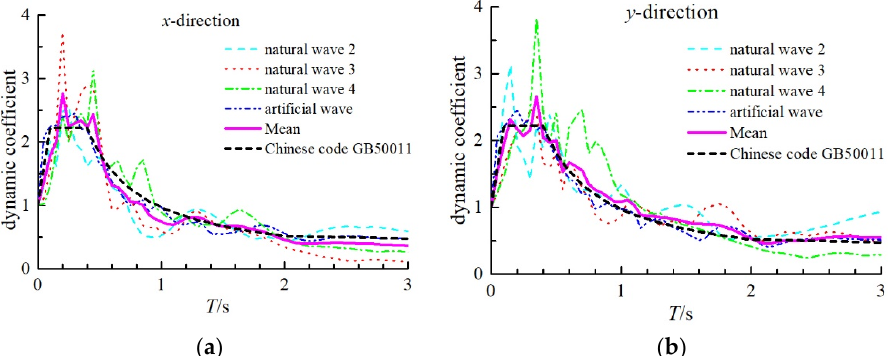
Figure 4. Elastic amplification factor spectra for 5% damping: ( a ) x ‐ direction; ( b ) y ‐ direction.